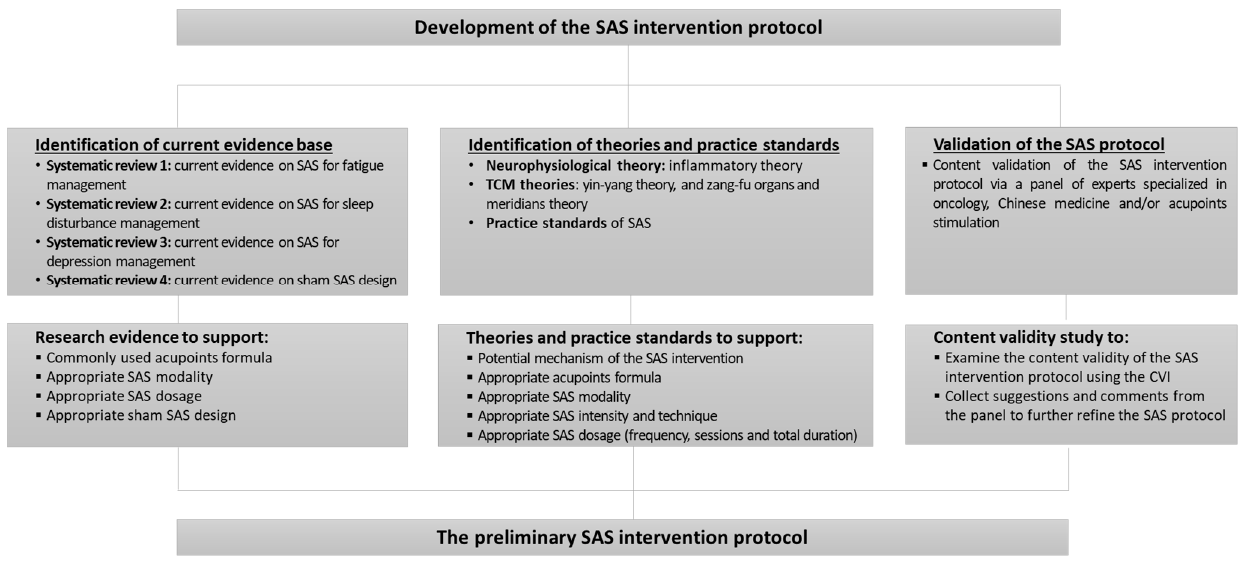
Figure 1. Overview of the study process. SAS: Somatic acupoints stimulation; CVI: Content validity index.